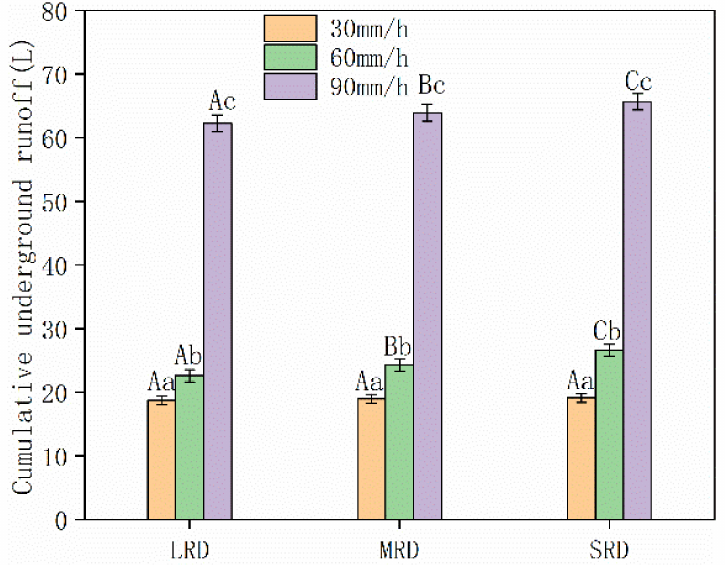
Figure 5. Cumulative underground runo ff under di ff erent rainfall